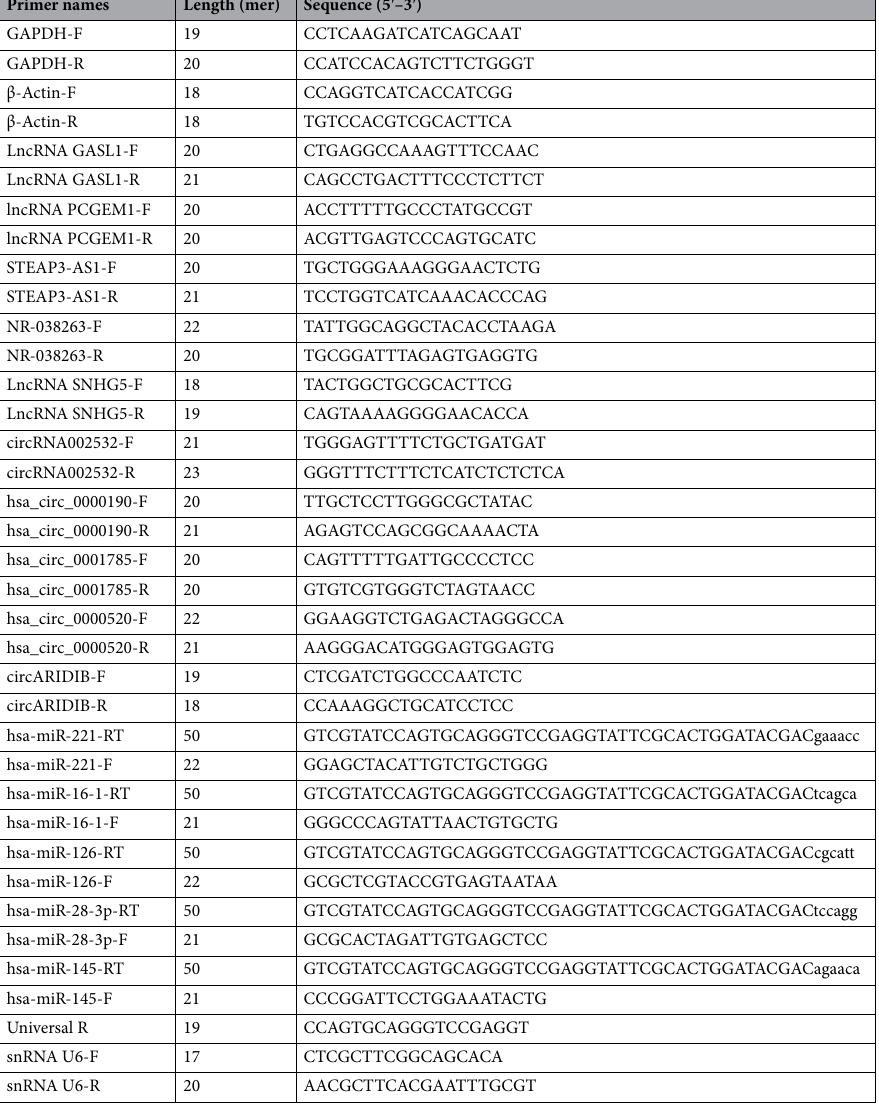
Table 1. Primer sequences of